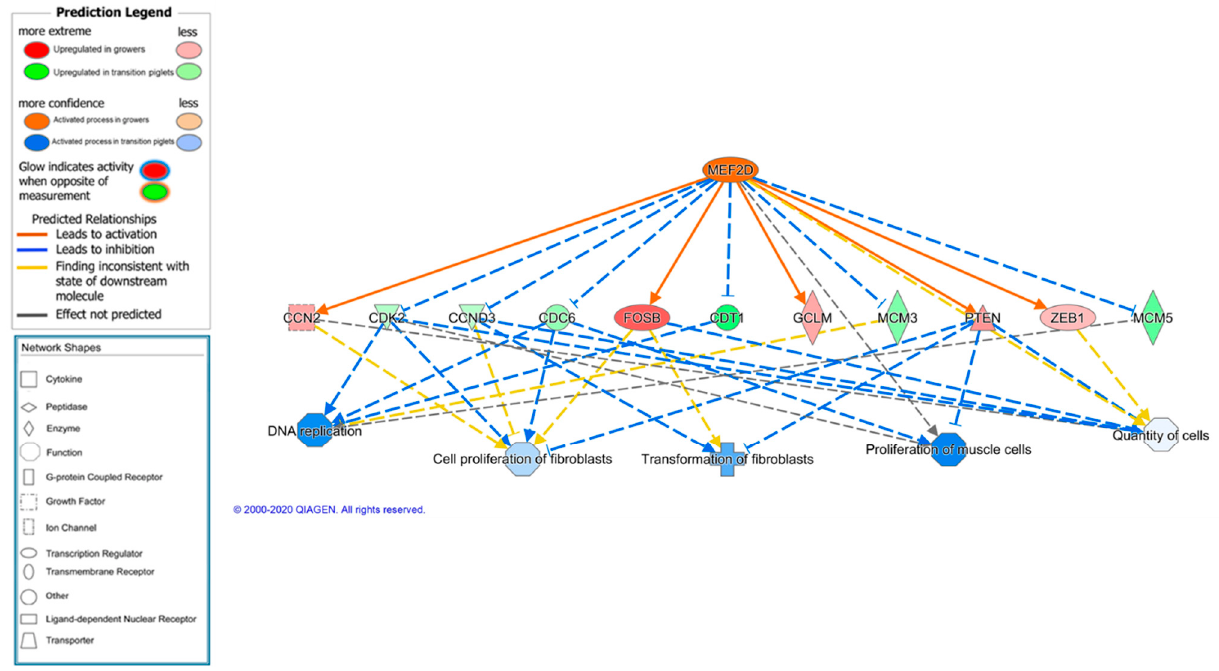
Figure 4. Causal network of MEF2D regulator, which is activated in growers and leads to predicted inhibition of several functions related to proliferation in growers (activated in transition piglets) (z-score = 3.317, p -value = 0.002).